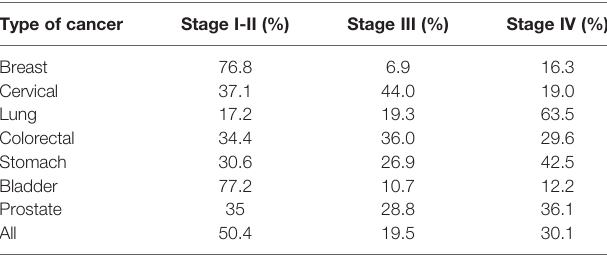
TABLE 1 | The percentage of cases in each stage at the time of diagnosis for common cancers in Armenia,